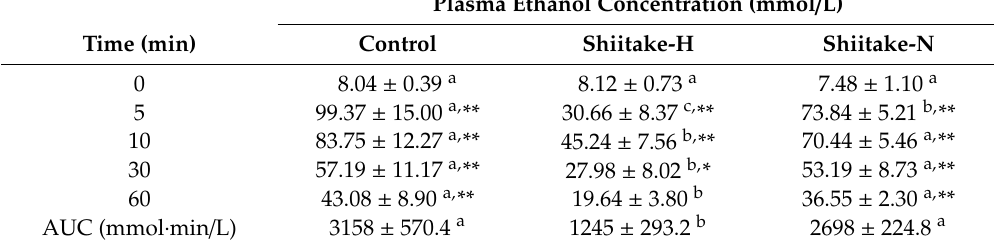
Table 5. E ff ects of shiitake extract on plasma ethanol concentration in the jejunum after injection of